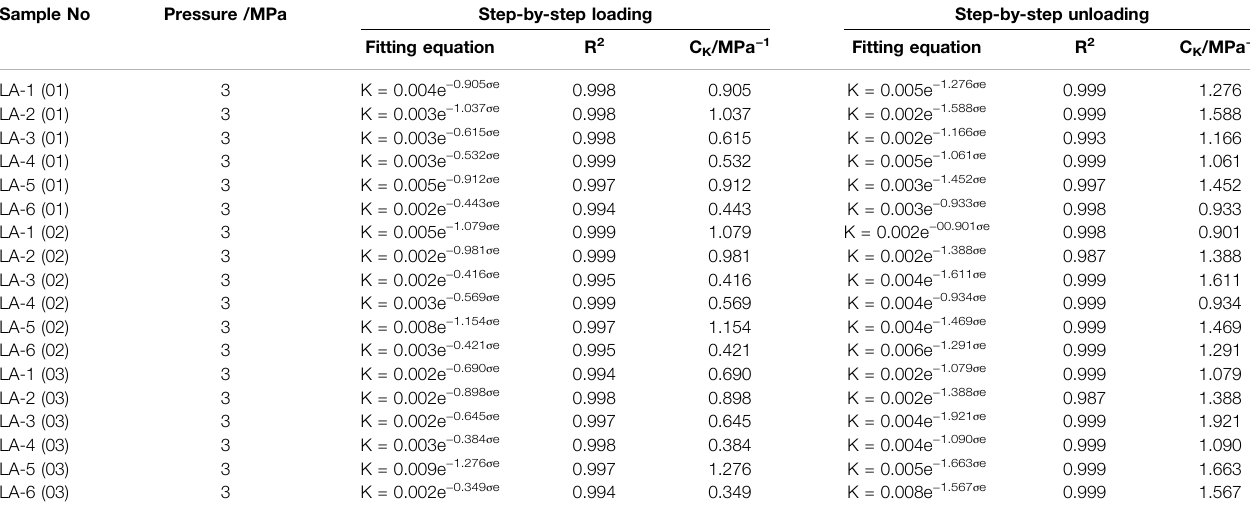
TABLE 3 | Fitting curve equation and stress sensitivity coef fi cient of permeability and effective stress of different surrounding rock combinations. Sample No Pressure